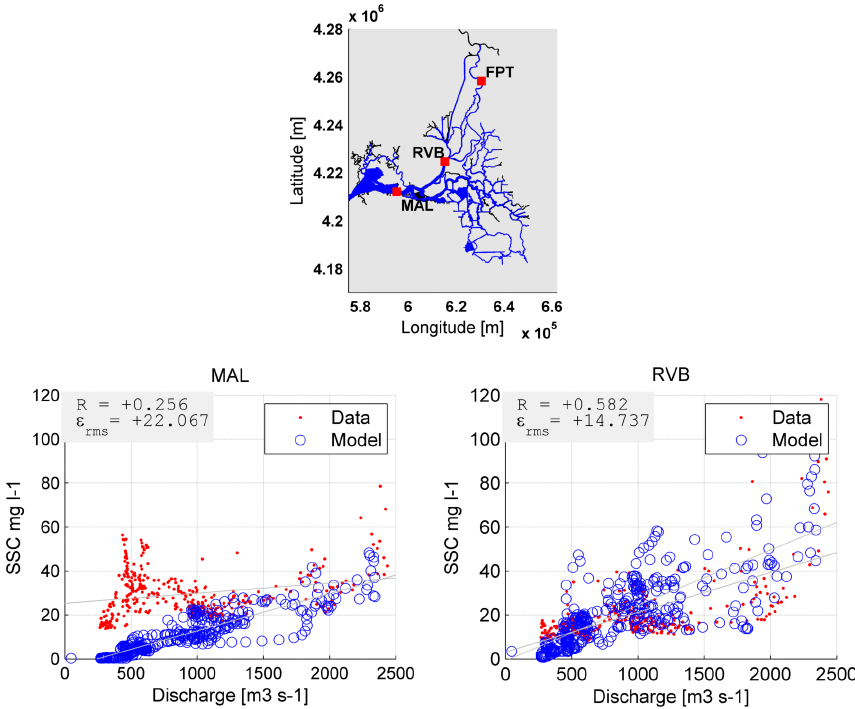
Figure B3. Scatter plot discharge versus SSC shown for MAL station on the left-hand (MAL) side and on the right-hand (RVB) side for RVB station. The red dots represent the data and the blue model